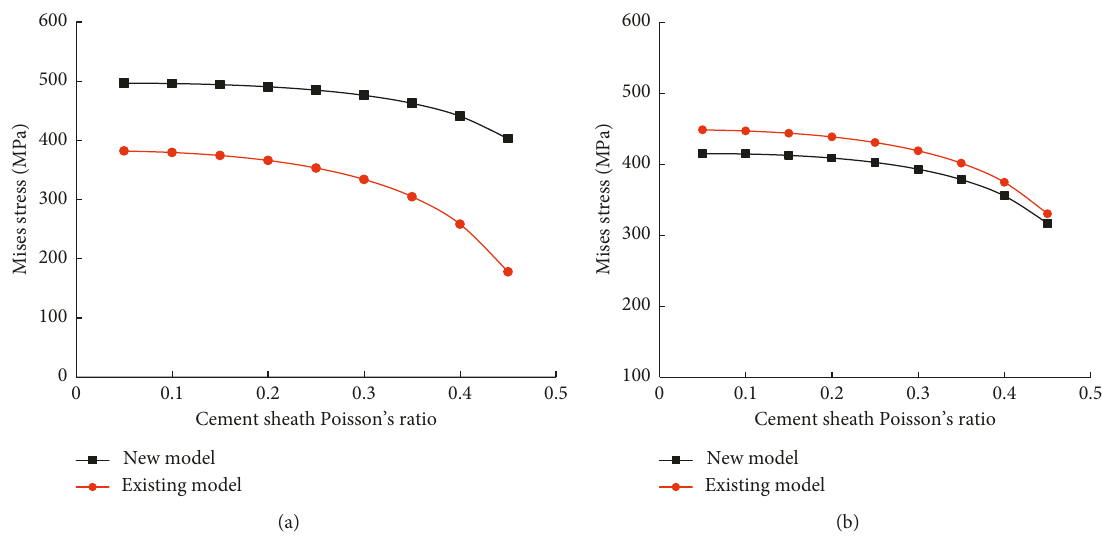
Figure 17: Casing Mises stresses for different Poisson’s ratios. (a) μ